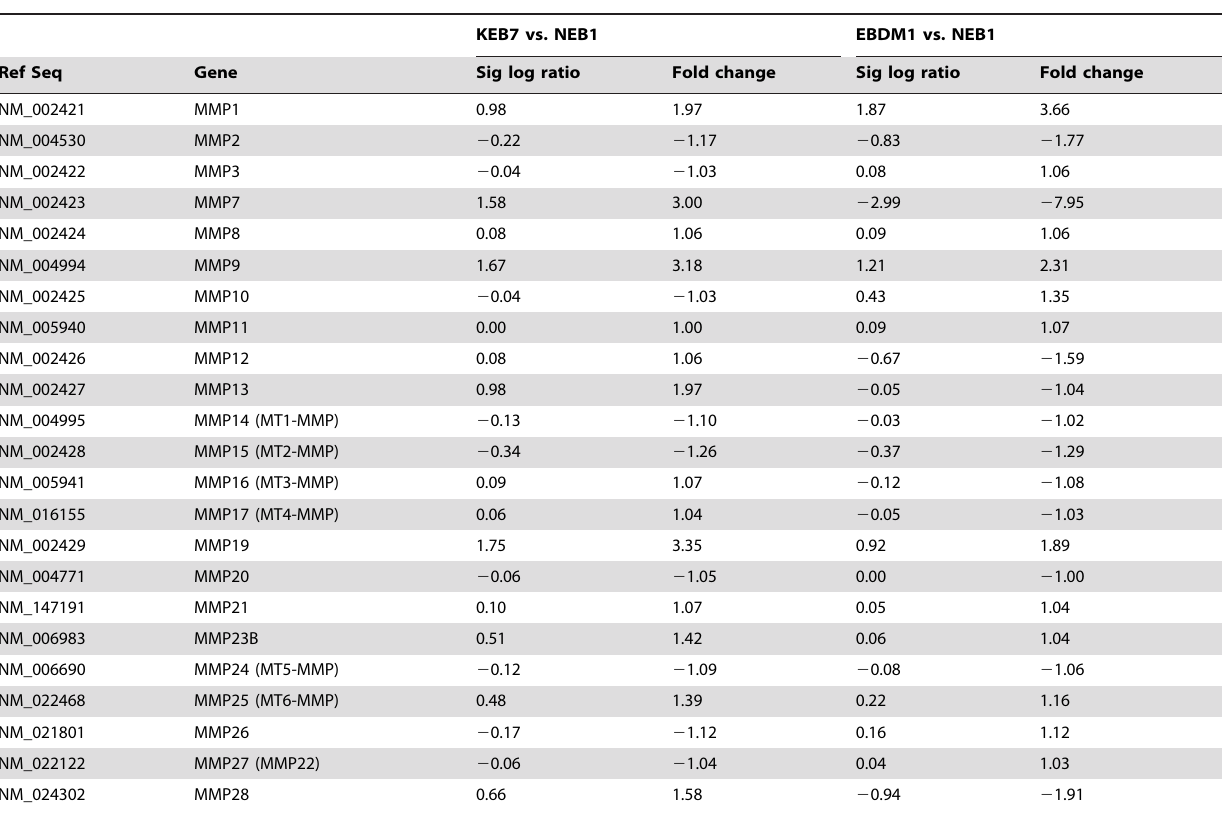
Table 3. Microarray analysis of matrix